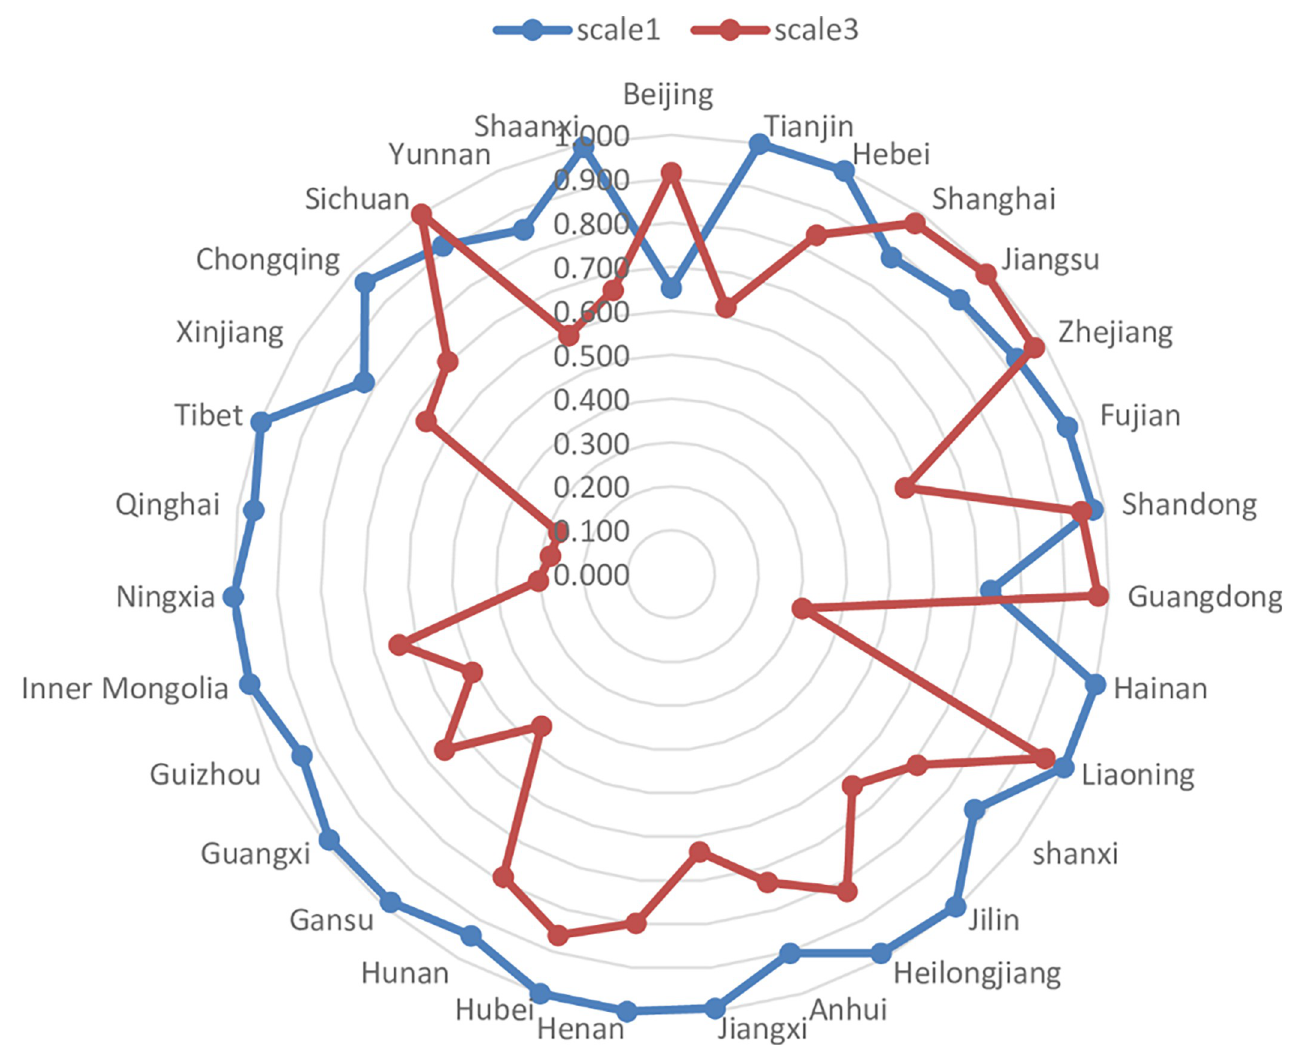
Fig 3. SE radar diagram of Stage 1 and Stage